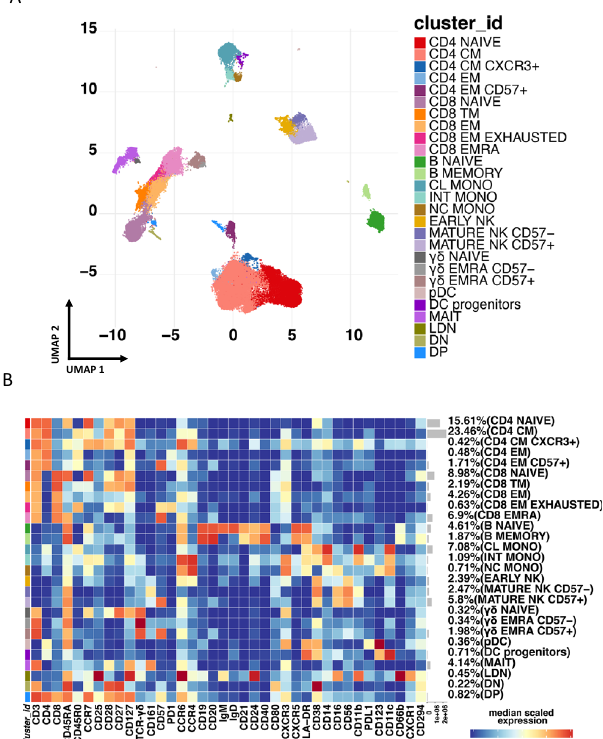
Fig. 1 Unsupervised analysis of mononuclear cells in peripheral blood and their characterization. A Uniform Manifold Approximation and Projection (UMAP) representation of PBMC landscape. Each color indicates a different cell population. CM, central memory; EM, effector memory; TM, transitional memory; CL, classical monocytes; INT, intermediate monocytes; NC, nonclassical monocytes; NK, natural killer cells; γδ , T cells expressing the γδ T-cell receptor; DC, dendritic cells; MAIT, mucosal- associated invariant T cells; LDN, low-density neutrophils; DN, CD4-, CD8- T lymphocytes; DP, CD4 + , CD8 + T lymphocytes. B Heatmap representing different clusters identi fi ed by FlowSOM, with relative identity and percentages in all groups of subjects. The color in the heatmap represents the median of the arcsinh, 0 – 1 transformed marker expression calculated over cells from all the samples, varying from blue for lower expression to red for higher